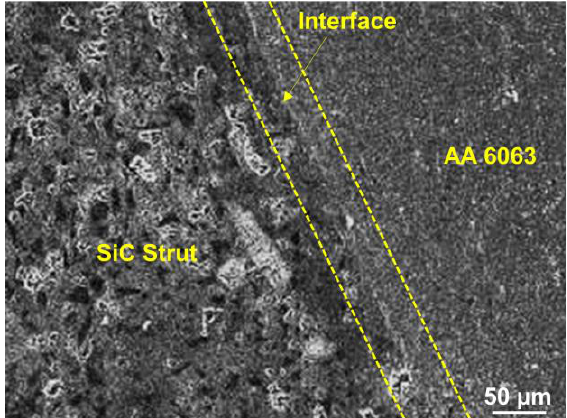
Figure 6. SEM Micrograph of AA 6063/SiC interface.